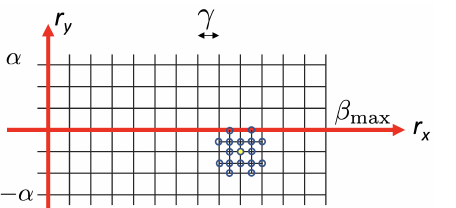
Figure 16. This figure illustrates the local increase in resolution of the error map around the local minimum. The initial local minimum obtained with γ step is shown as a yellow filled circle.